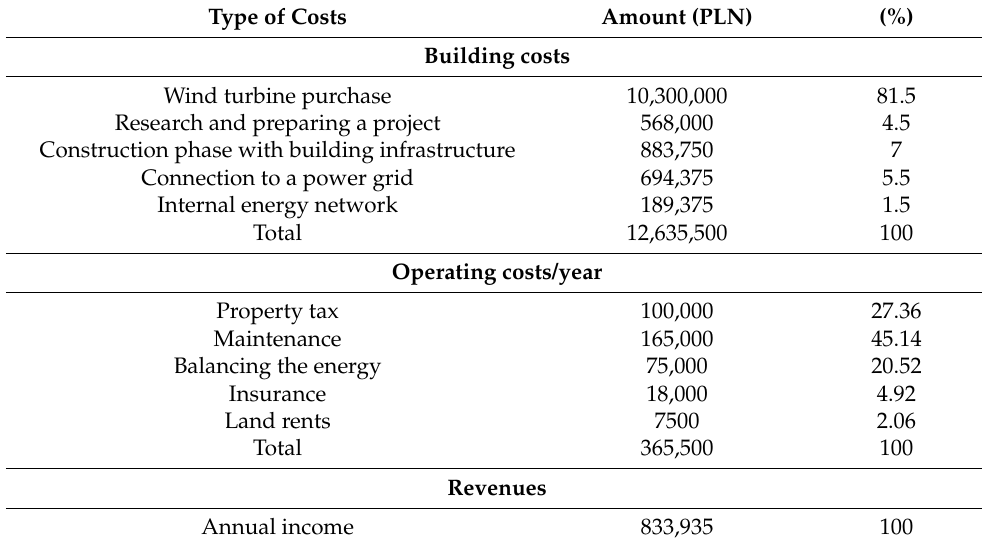
Table 5. Costs and revenues for building one wind turbine in